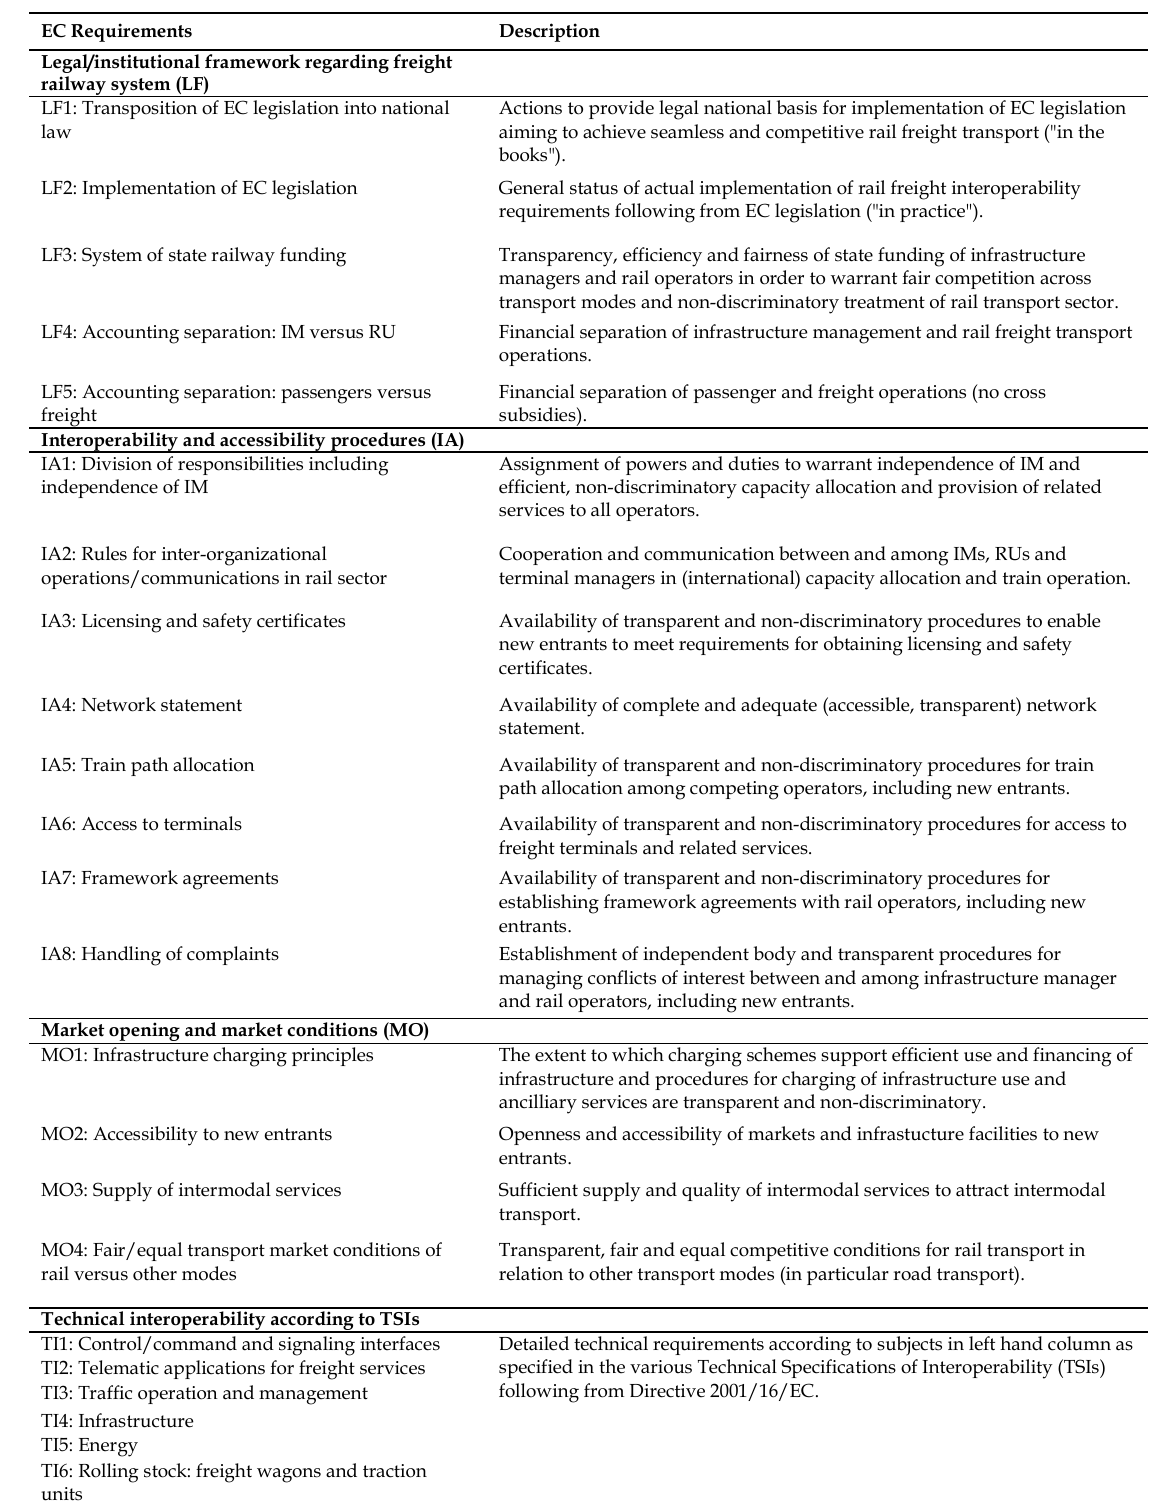
Table 1. EC requirements to achieve seamless rail freight